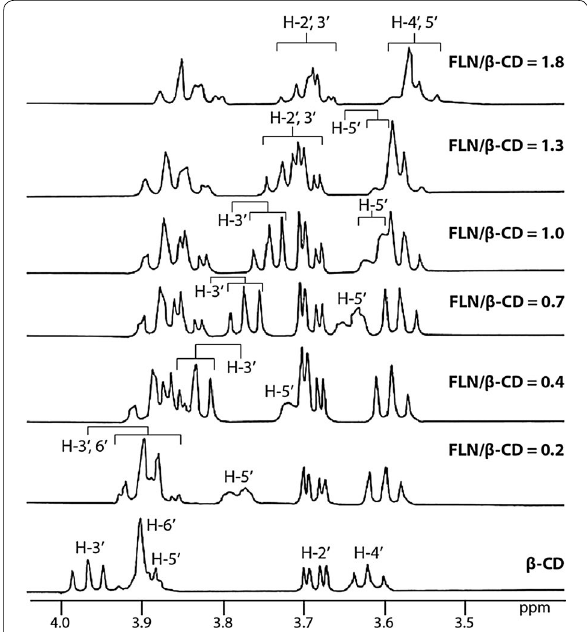
Fig. 5 A part of 1 H NMR spectra (500 MHz) showing protons of β-CD in the absence, as well as in the presence, of varying amount of FLN